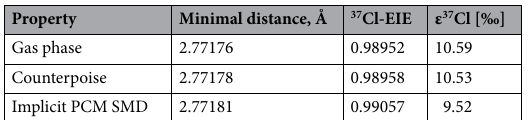
Table 3. Influence of counterpoise BSSE correction and continuum solvent model.